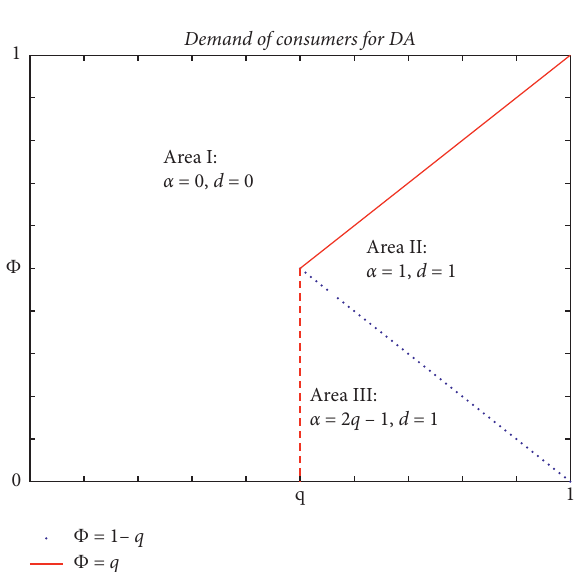
Figure 3: The impact of application fee and certification accuracy on the consumer’s demand for